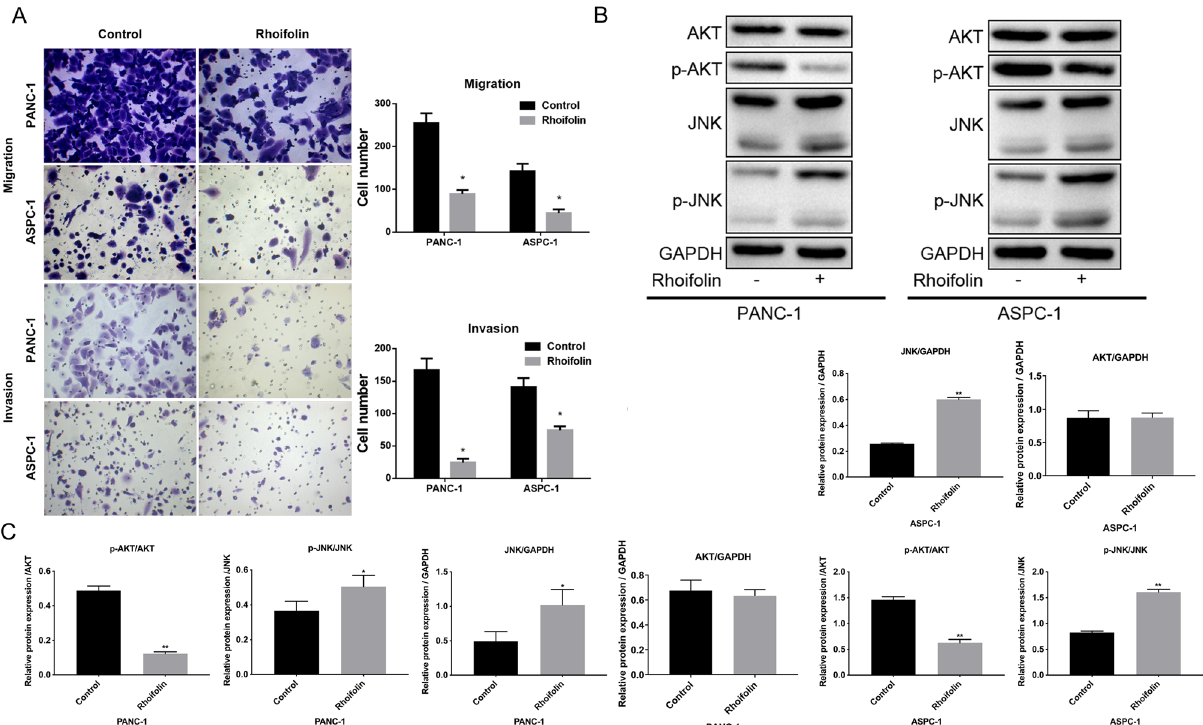
Figure 4. Rhoifolin prevented the migration and invasion, and regulated AKT/JNK pathway in pancreatic cancer cells. PANC-1 cells or ASPC-1 cells were dealt with 100 µg/ml rhoifolin. (A) Transwell was utilized to determine the migration and invasion. (B) JNK, p-JNK, AKT, and p-AKT expressions were analyzed via western blotting analysis in the processed PANC-1 and ASPC-1 cells. (C) Quantitative analysis of p-AKT/AKT, AKT/ GAPDH, p-JNK/JNK and